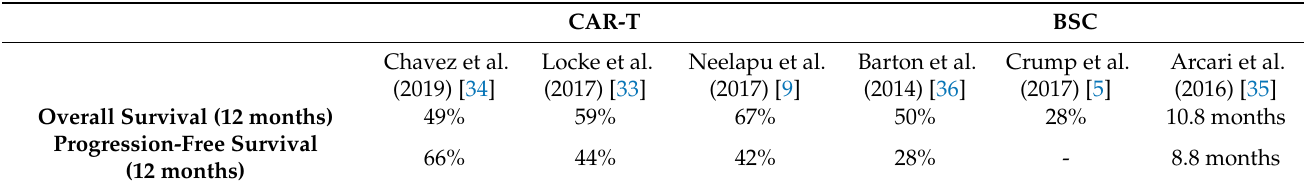
Table 1. Efficacy parameters: overall survival and progression-free survival at 12-months: CAR-T vs.